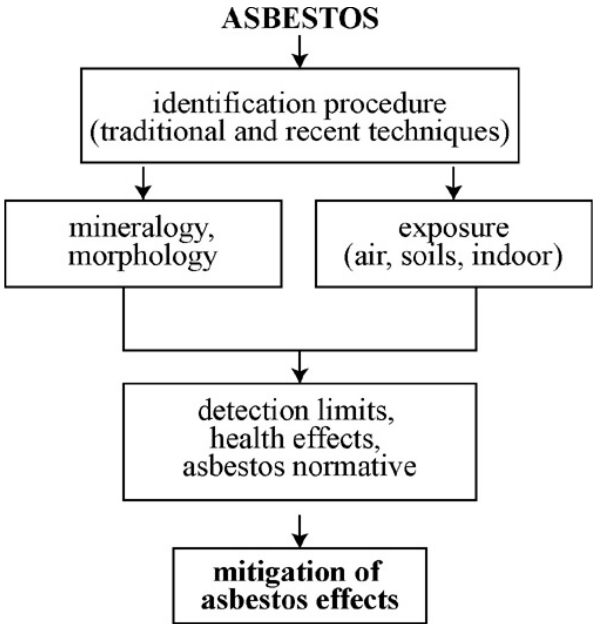
Fig. 1. Flowchart correlating the asbestos hazard to mitigation ef- fects in natural